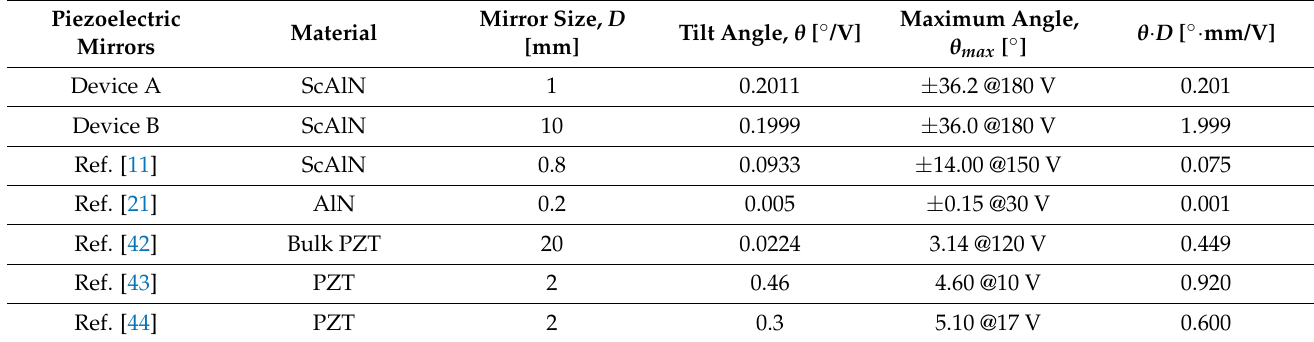
Table 4. Static performance comparison between the MEMS mirrors presented here and in the literature. Piezoelectric